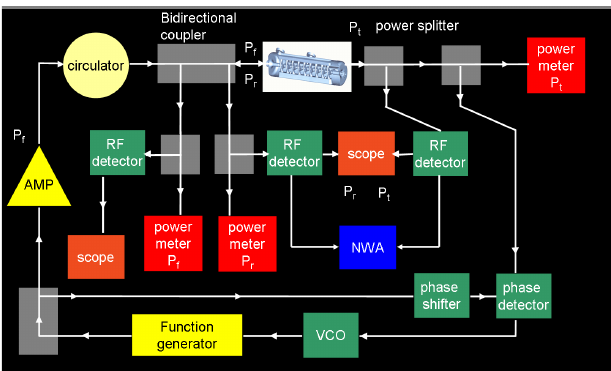
FIG. 30. (Color) The rf signals of the CH cavity at high fields: Reflected signal (green), transmitted (pickup) signal (magenta), and forwarded signal (yellow). The time scale is 100 ms per division.FIG. 28. (Color) Principle of the rf control system to operate the